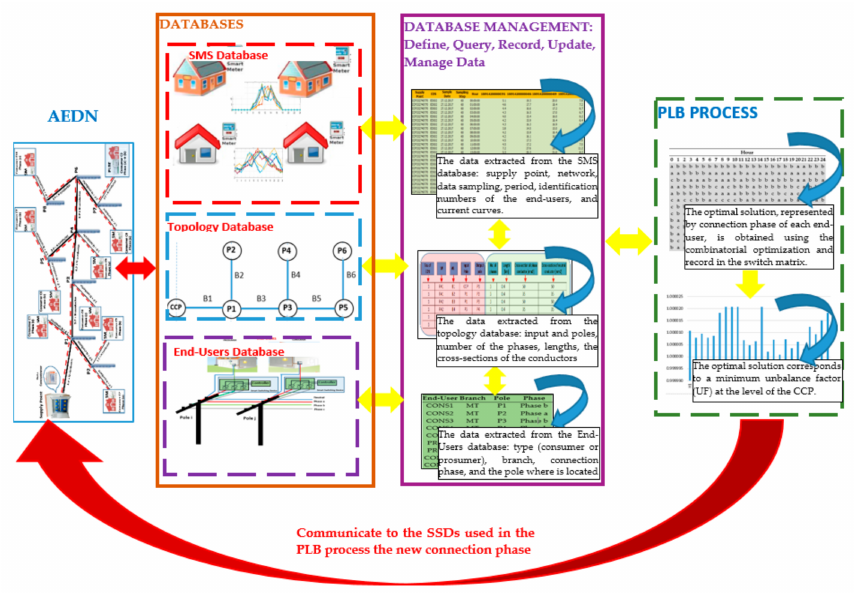
Figure 4. The flow-chart of the proposed coordinated control methodology.